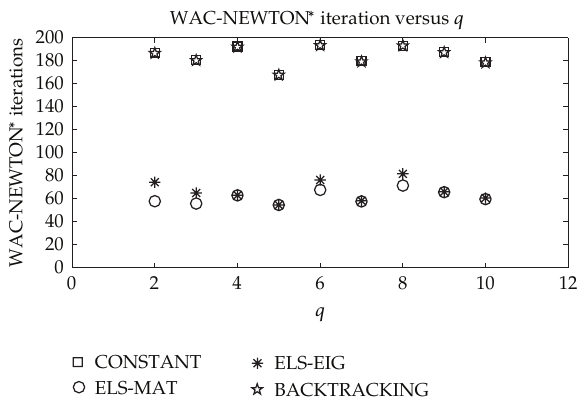
Figure 6: SDP-CUT iterations against the number of constraints q .